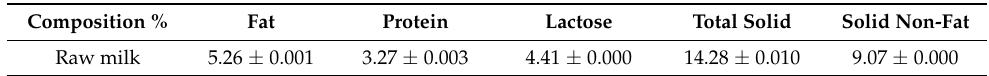
Table 1. Composition of the untreated raw milk before removal of fat as analyzed by Milkoscan ( n = 2). Composition % Fat Protein